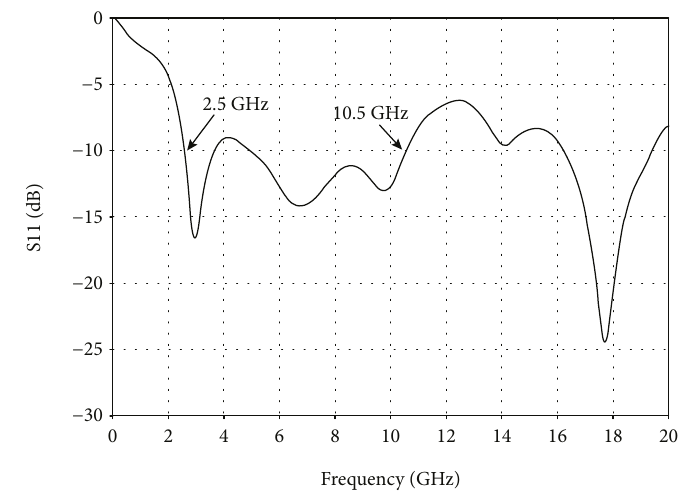
Figure 2: Simulated S11 parameter of the conventional circular monopole.